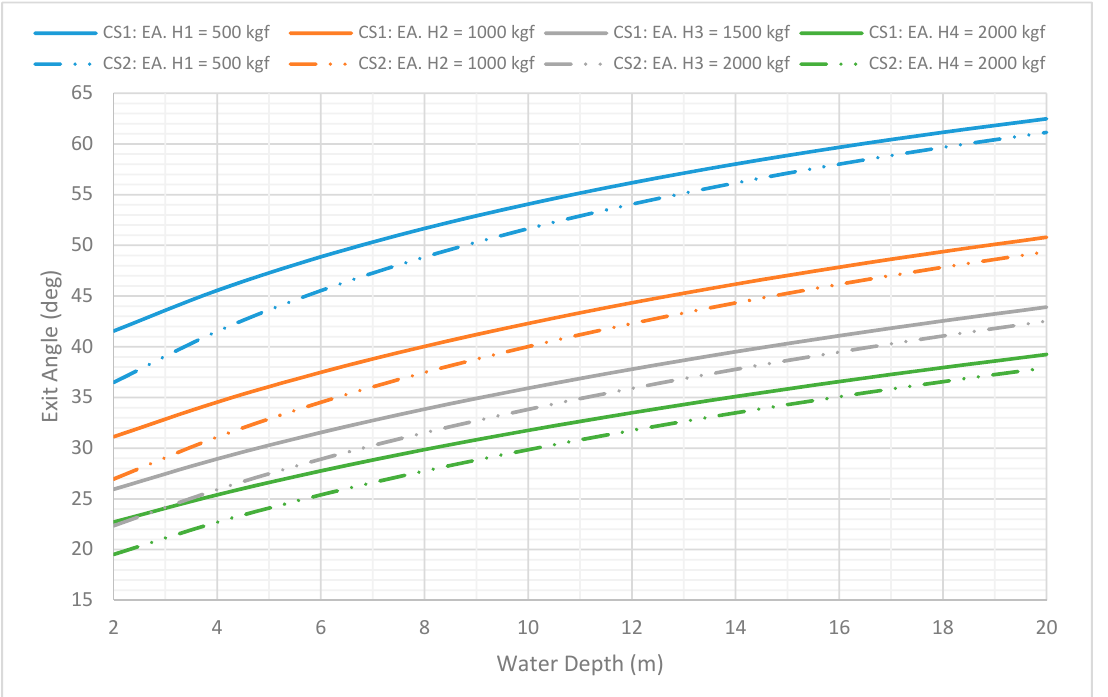
Figure 12. Exit angle ( θ ) assuming CS1 & CS2 using different bottom tensions (500 kgf–2000 kgf) and water depths (2 m–20 m).